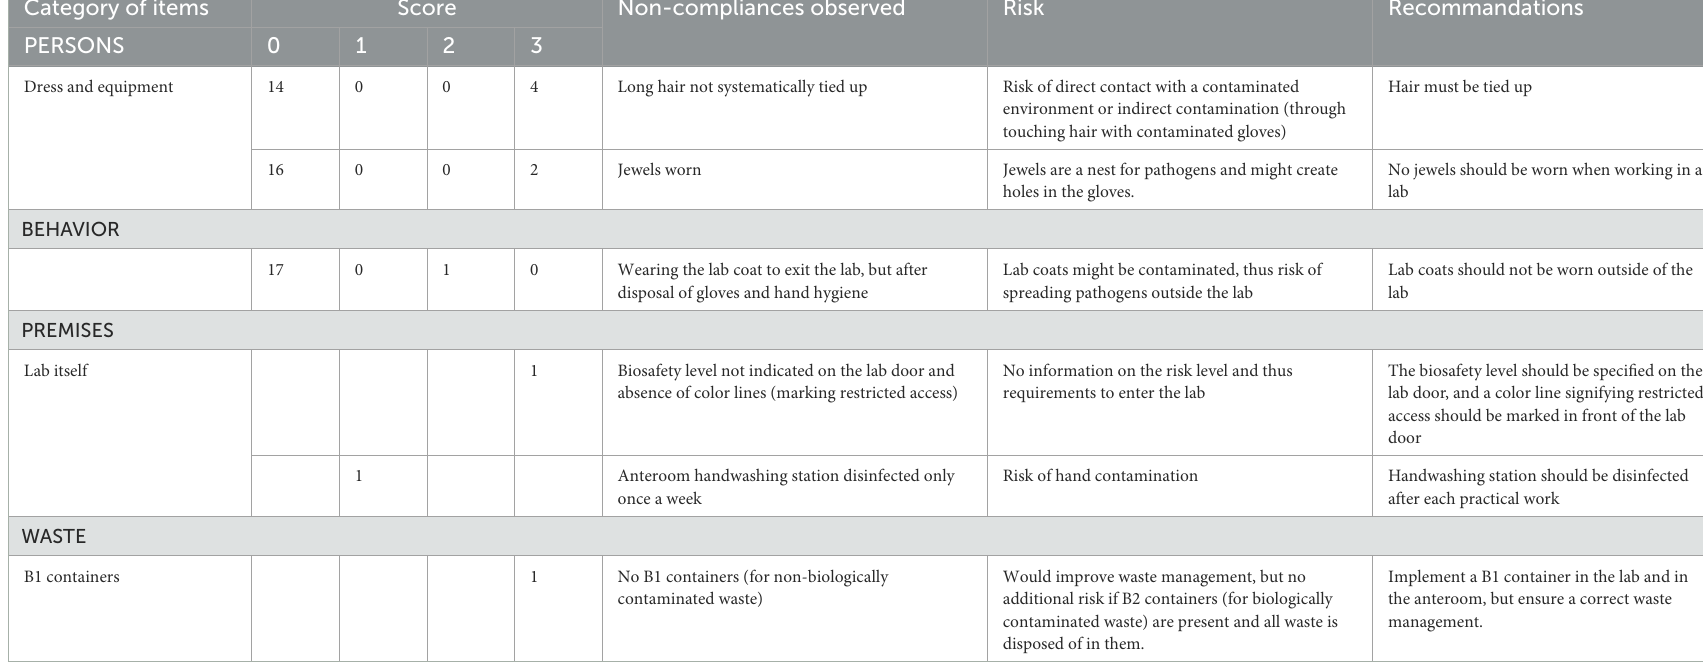
TABLE 4 Main biosecurity deficiencies observed when performing the internal audit in the virology lab, per category of items. Category of